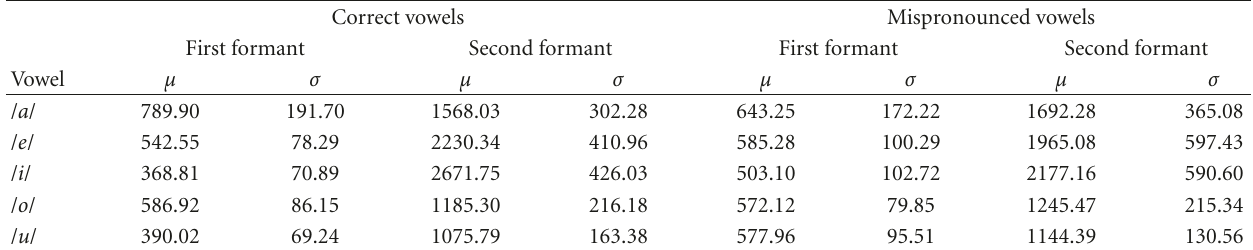
Table 8: Mean ( μ ) and standard desviation ( σ ) for the formants in the impaired corpus.